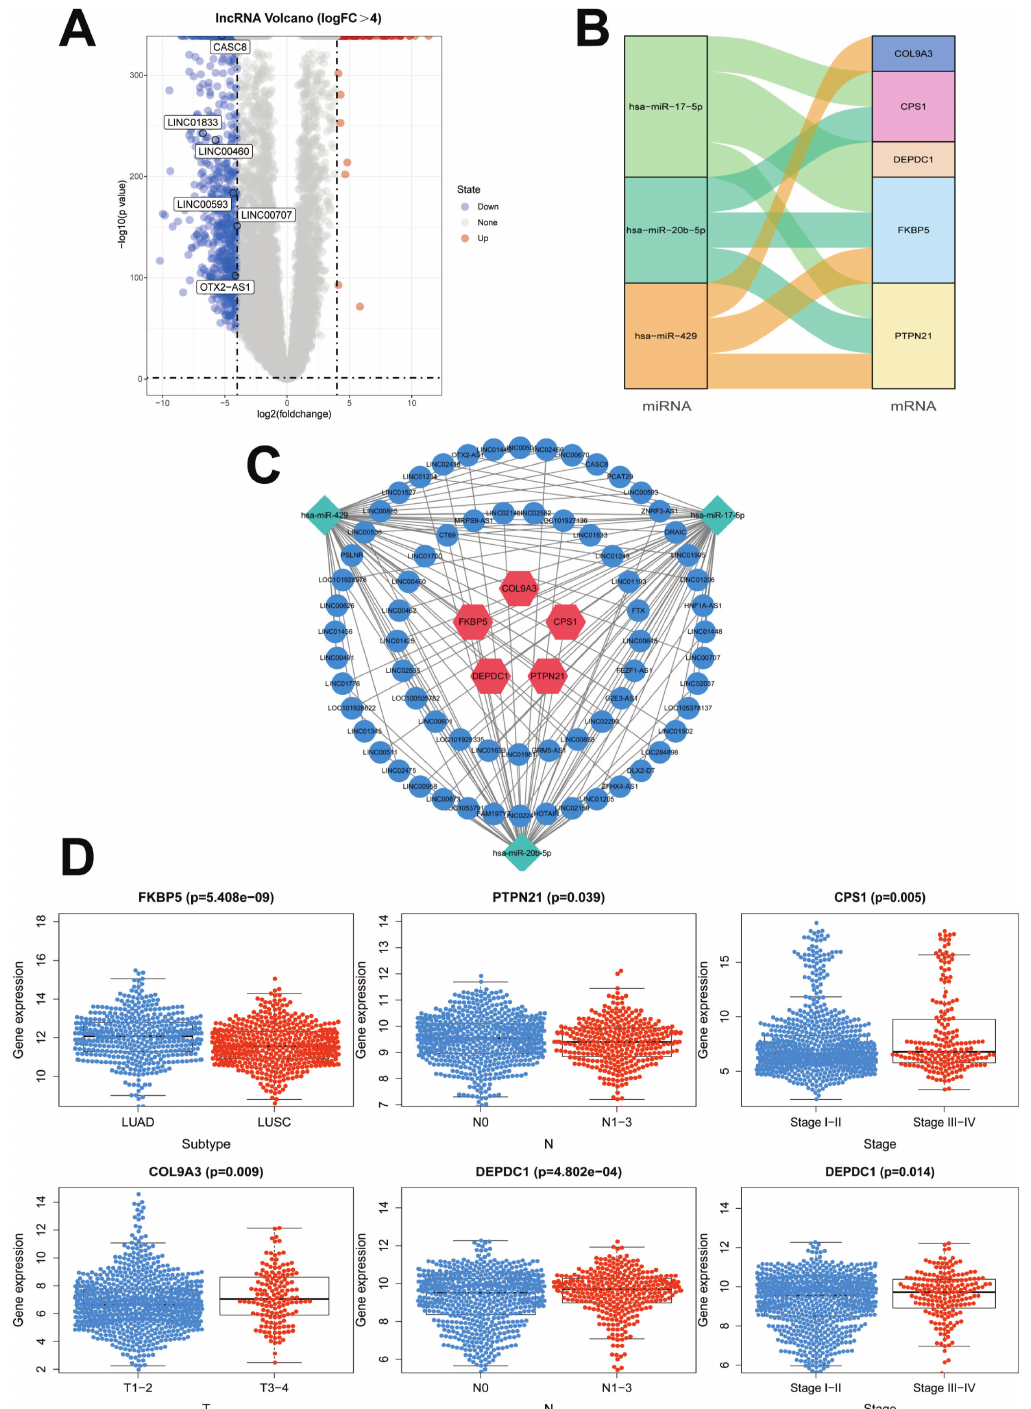
Fig 6. Construction of a lncRNA–miRNA–mRNA ceRNA network. (A) Volcano map of 69 significant DElncRNAs. (B) Correlation between the five prognostic mRNAs and their corresponding miRNAs. (C) A ceRNA network was constructed containing five mRNAs, three miRNAs, and 69 lncRNAs for NSCLC prognosis. (D) Clinicopathological significance of FKBP5 , DEPDC1 , CPS1 , COL9A3 , and PTPN21 in NSCLC. ceRNA, Competing endogenous RNA; DElncRNAs, differentially expressed lncRNAs; NSCLC, non-small cell lung cancer.